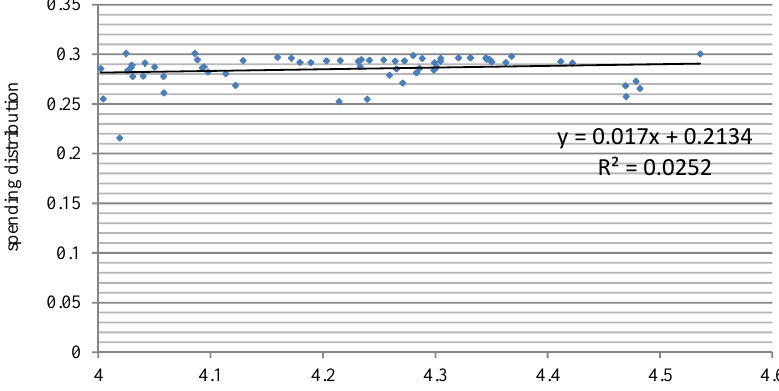
Source: own calculations based on ICP data. Figure 6. Linear regression for link "the absolute size of consumer spending — a measure of diversity of consumer spending (between-group entropy) for 63 countries with highest household spending